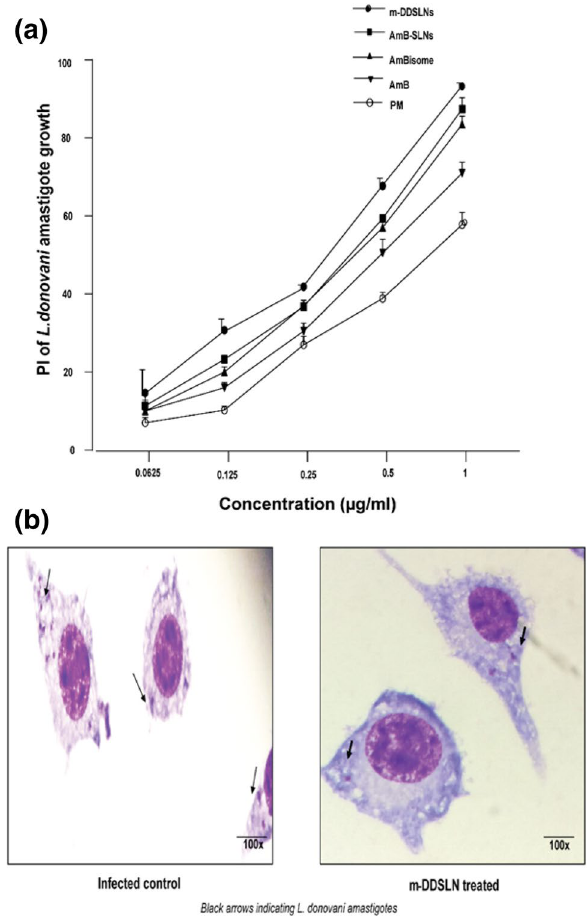
Figure 6. ( a ) Percentage inhibition of m-DDSLNs, AmB-SLNs, AmBisome, AmB and PM against L. donovani - infected J774A.1 macrophage, ( b ) microphotographs of m-DDSLNs treated and untreated L. donovani -infected J774A.1 macrophages. Results are presented as mean ± standard deviation (n = 3).